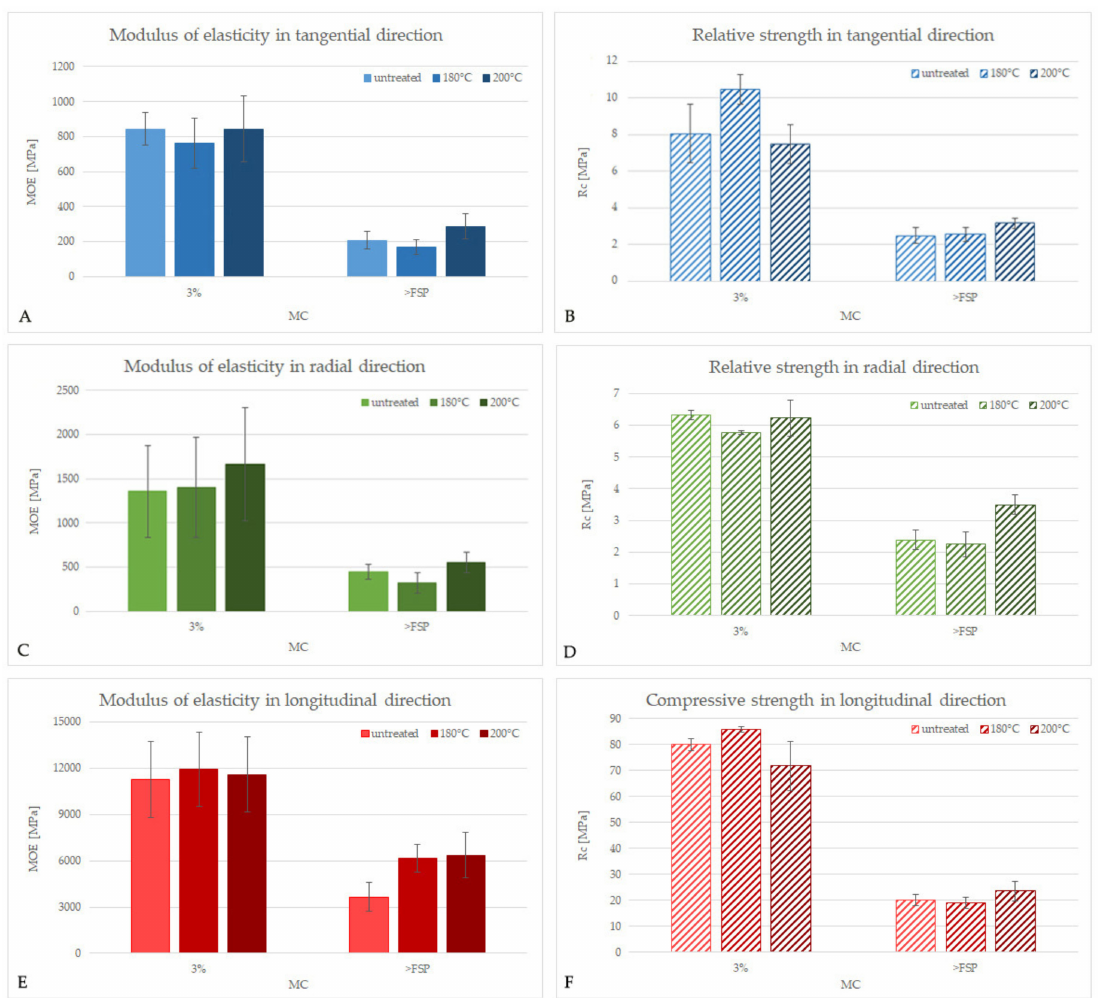
Figure 2. Modulus of elasticity (MOE) and relative / compressive strength (R c ) for unmodified and thermally-modified ash measured in the tangential ( A , B ), radial ( C , D ), and longitudinal direction ( E , F